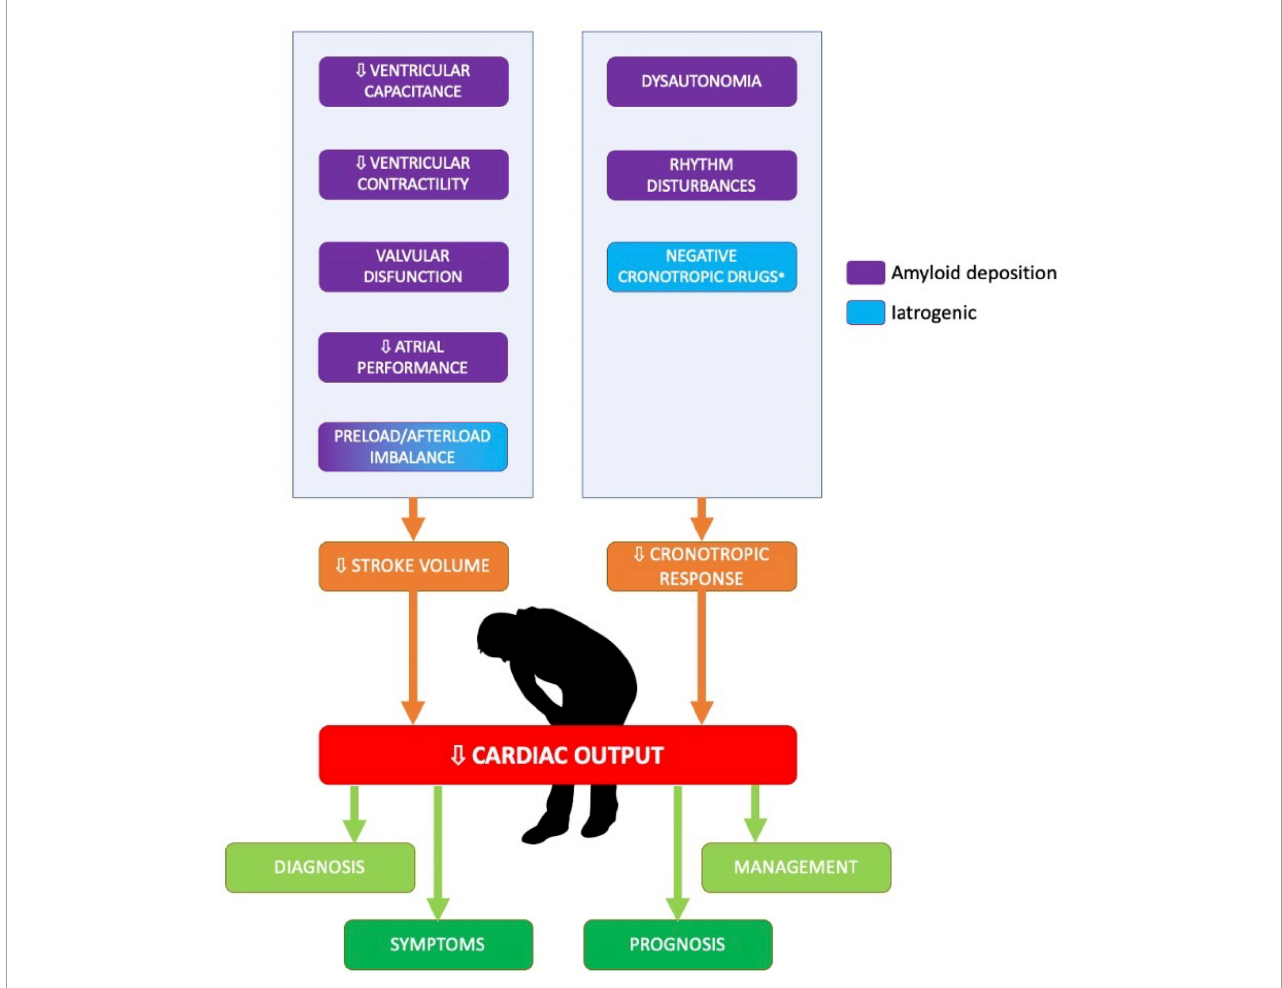
FIGURE1 Determinants of low stroke volume and low cardiac output in patients with cardiac amyloidosis. The figure summarized the main determinants of low cardiac output in patients with cardiac